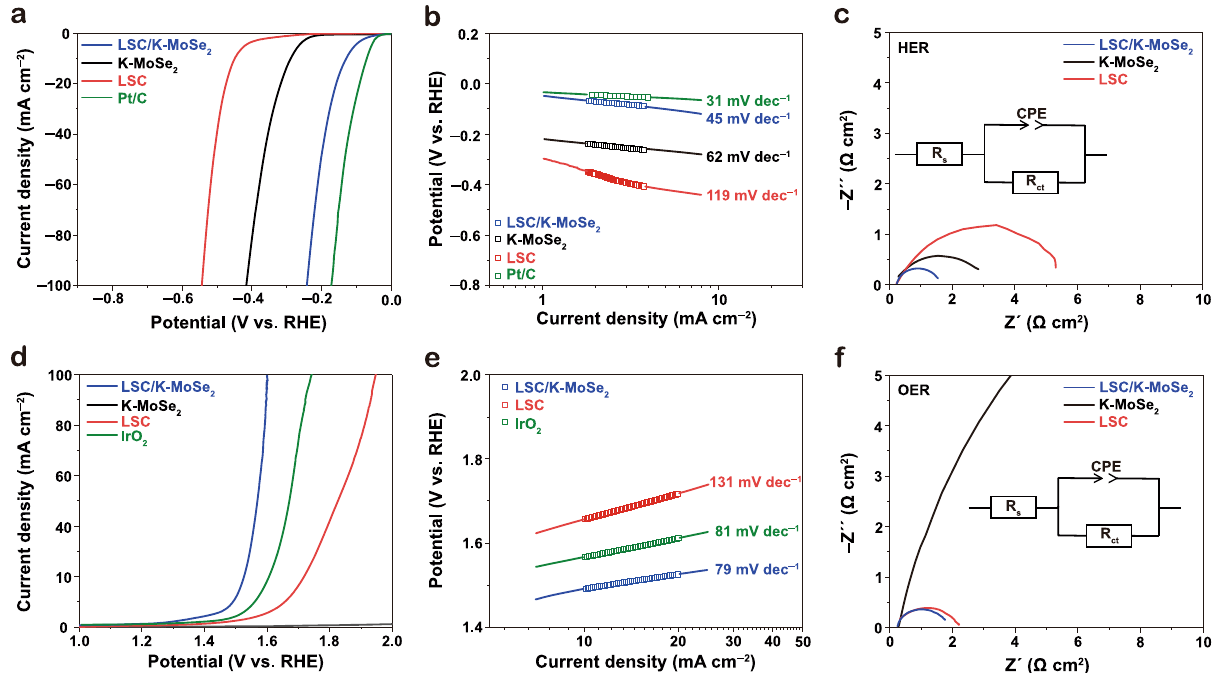
Fig. 2 Electrocatalytic HER and OER performances of LSC/K-MoSe 2 , K-MoSe 2 , and LSC. a , d HER and OER polarization curves recorded in N 2 -saturated 1 M KOH at a scan rate of 5 mV s − 1 . b , e Corresponding Tafel slopes of the HER and OER pro fi les derived from the polarization curves. c , f EIS analysis of HER and OER for LSC/K-MoSe 2 , K-MoSe 2 , and LSC. The Nyquist plots comprise real ( Z ′ ) and imaginary ( Z ″ ) parts fi tted as x and y axes,